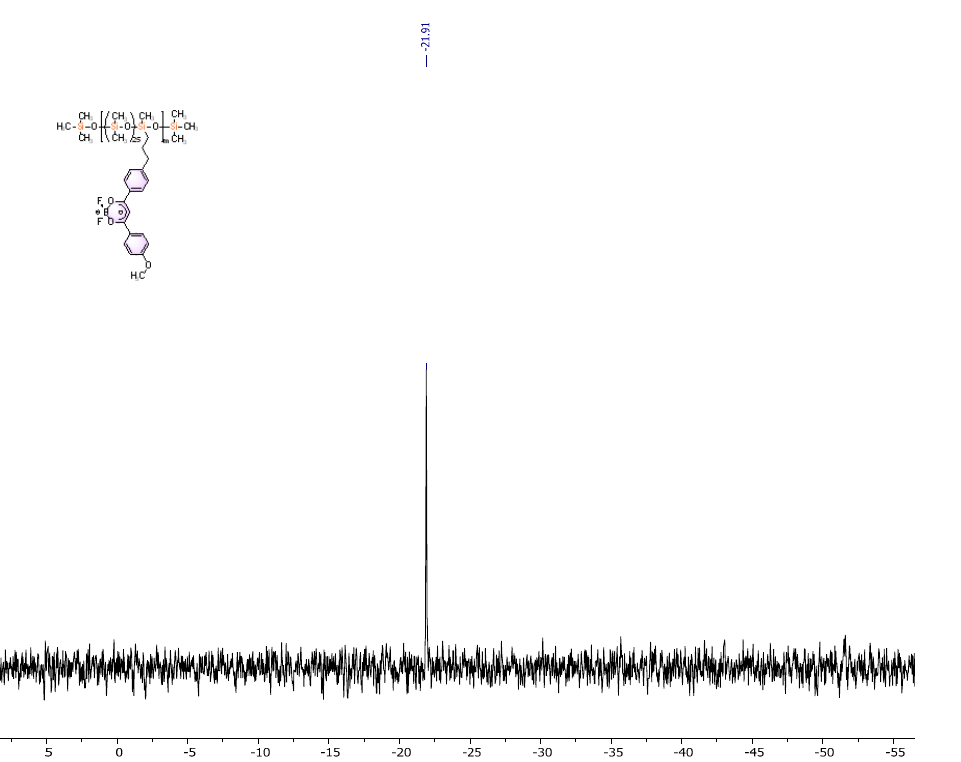
Polymers 2022 , 14 , x FOR PEER REVIEW Figure 6. 29 Si NMR spectrum of polymer 3 a in CDCl 3 . Figure 6. 29 Si NMR spectrum of polymer 3 a in CDCl 3 .